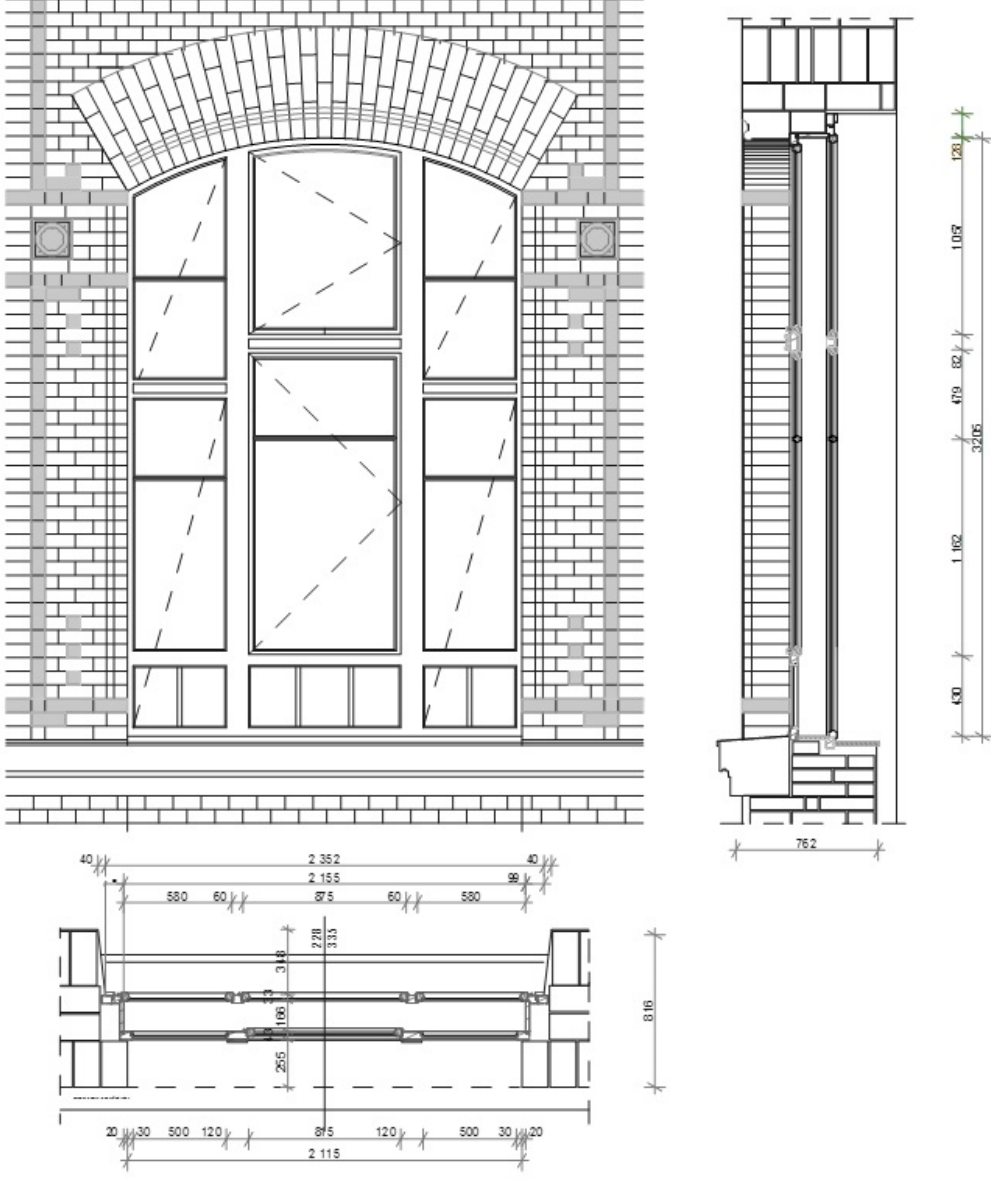
Figure 4. View and sections of the window in its original state.